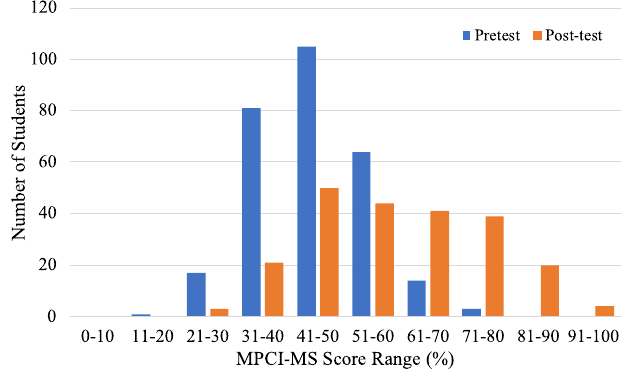
FIG. 4. Histogram of students ’ scores on the MPCI-MS, pretest ( N ¼ 289 ) and post-test ( N ¼ 223